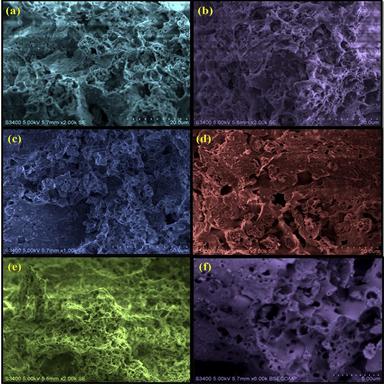
SEM images of optimized (a, b) CAT, (c) CATC, (d, e & f) CATC:M+ (M+ = K, Na, Li) NPs, respectively.